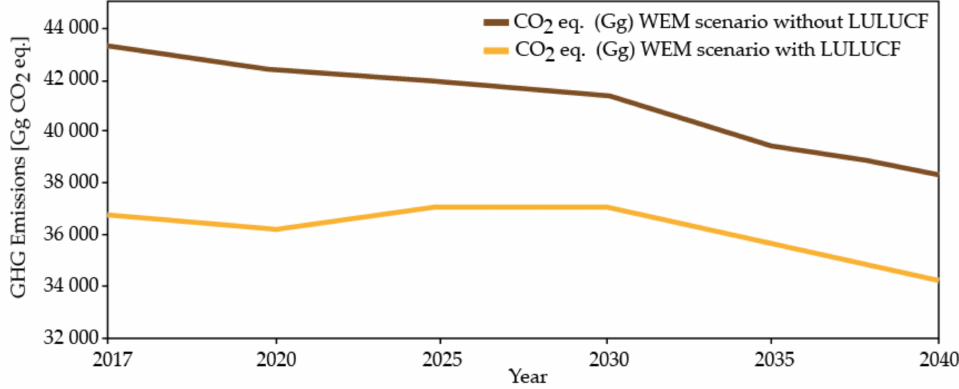
Figure 11. Projections of greenhouse gas emissions prepared according to the WEM scenario